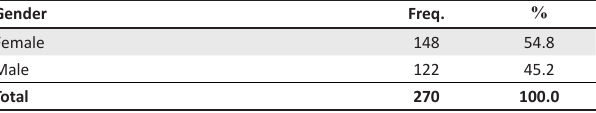
TABLE 1h: Background of